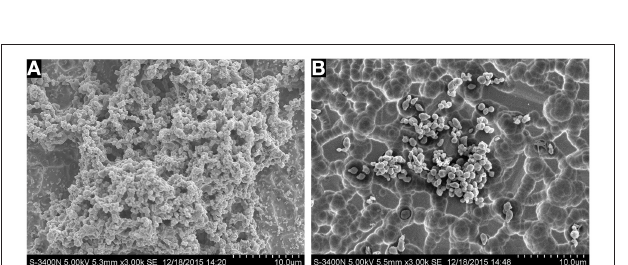
FIGURE 2 | (A) Biofilm formation of S. suis without tylosin. (B) Biofilm formation of S. suis with 1/4 MIC tylosin treatment.